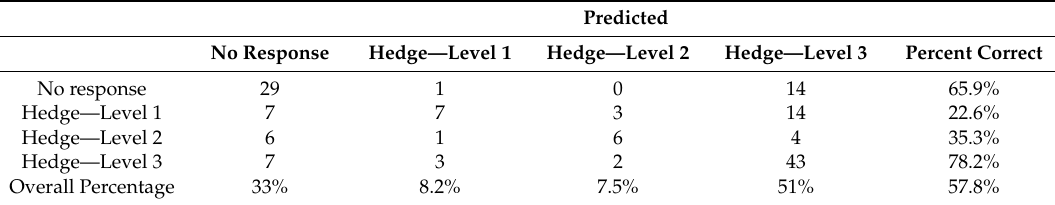
Table 8. Classifications of groups based on the model’s predictive